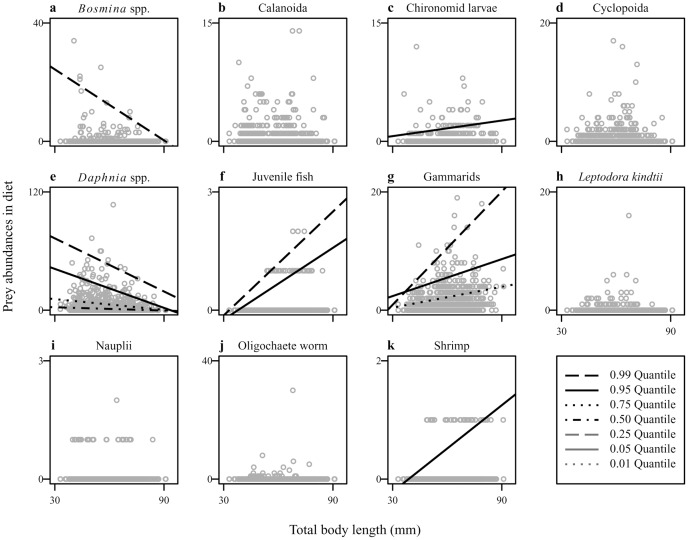
Scatter plot showing the relationships between prey abundance in the diet and fish body size.(a) Bosmina spp., (b) Calanoida, (c) chironomid larvae, (d) Cyclopoida, (e) Daphnia spp. (f) juvenile fish, (g) gammarids, (h) Leptodora kindtii, (i) nauplii, (j) Oligochaeta, and (k) shrimps. Only significant (p<0.05) quantile regressions are shown.